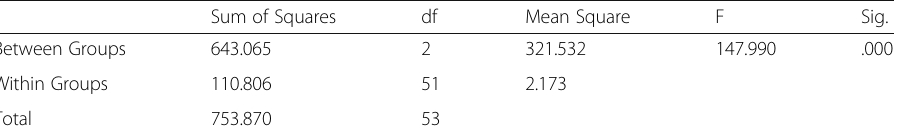
Table 5 One-way ANOVA (post-test) Sum of Squares